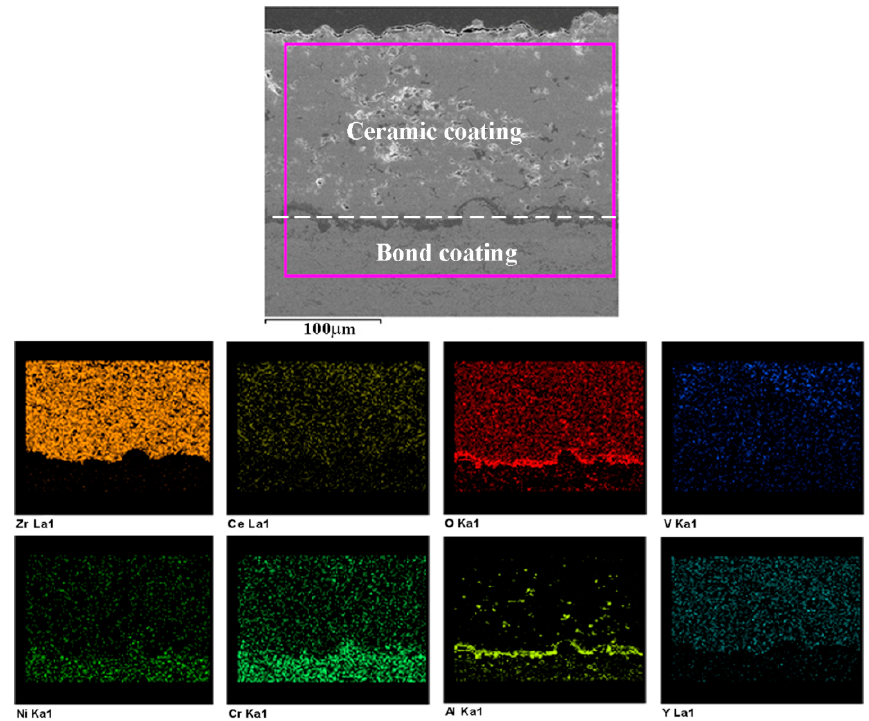
Figure 13. EDS elemental mapping of the cross section of the plasma-sprayed specimen after the hot corrosion test. Table 4. EDS compositions of plasma-sprayed (Figure 13), dotted (Figure 14), and DA (Figure 15) coatings after the hot corrosion test.